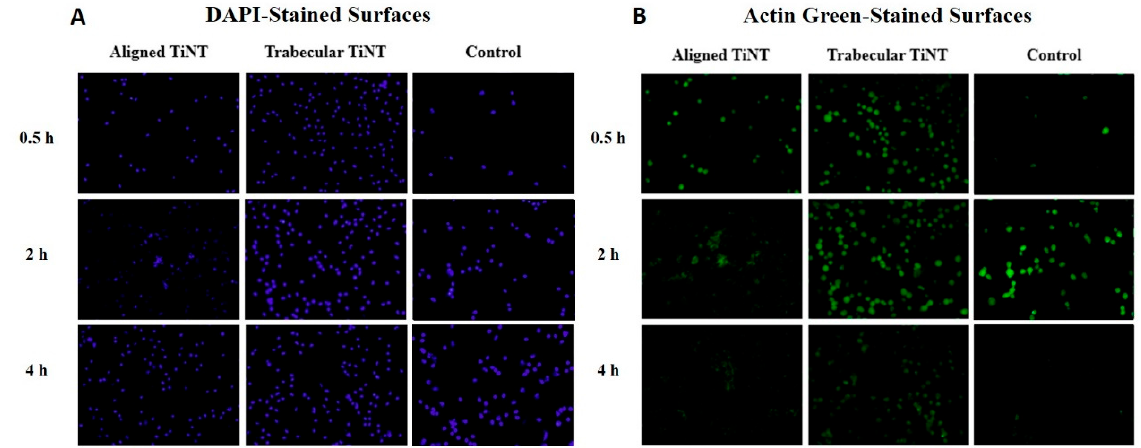
Figure 2. Representative fluorescent images of dihydrochloride (DAPI)-stained ( A ) and Actin Green-stained ( B ) aligned TiNT, trabecular TiNT, and control surfaces at three early timepoints, 0.5 h, 2 h, and 4 h.